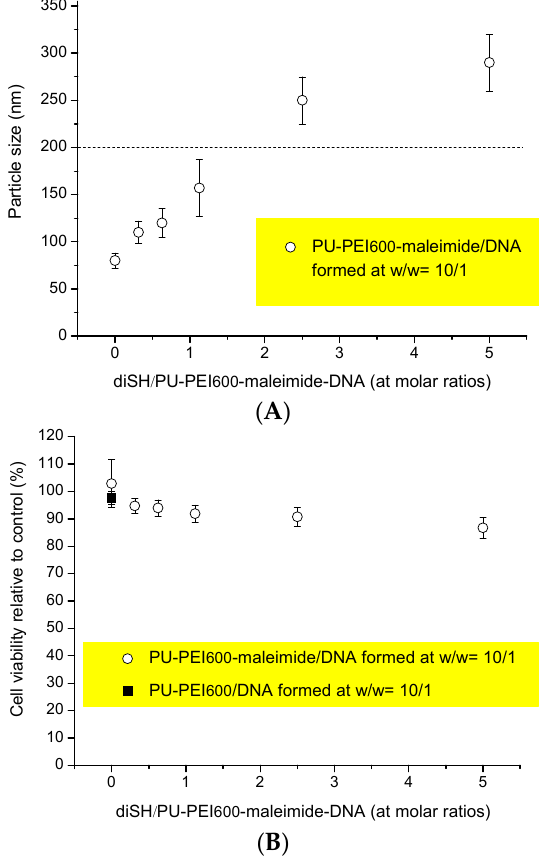
Figure 4. ( A ): Particle sizes of the conjugates of PU-PEI 600 -maleimide/DNA complexes at various diSH/PU-PEI 600 -maleimide-DNA molar ratios; ( B ) Cytotoxicity of the conjugates of PU-PEI 600 -maleimide/DNA complexes in COS-7 cells. Data are presented as mean ± SD ( n = 3).